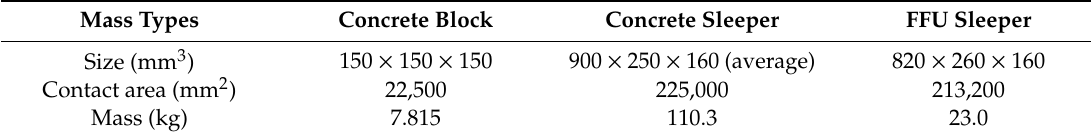
Table 1. Di ff erent types of mass.